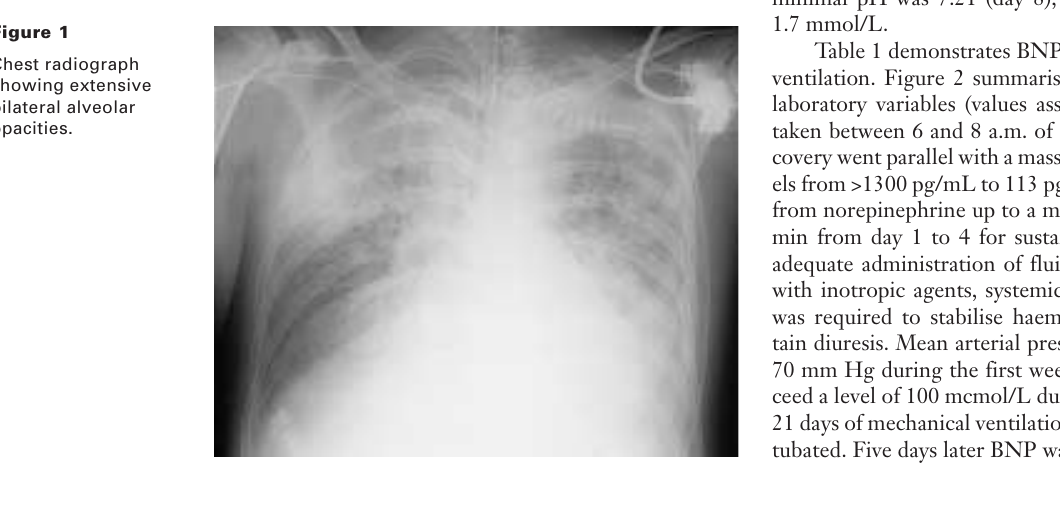
Time course of BNP, oxygenation, and haemodynamics. Note that the left- sided scale (until 1500) concerns BNP levels, whereas the right-sided scale (until 400) concerns the other three vari- ables. Treatment with iNO and methylpred- nisolone are indi-